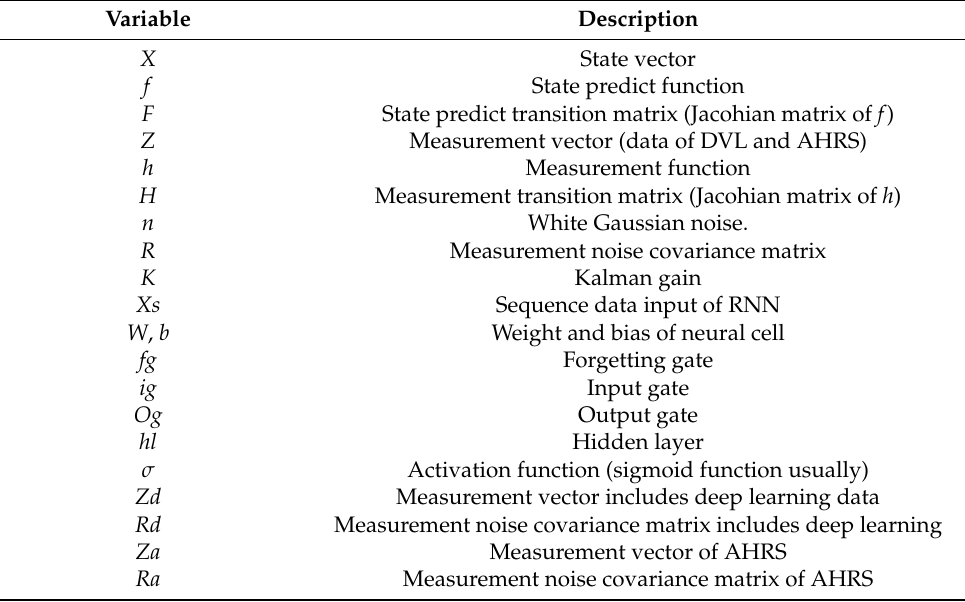
Table 5. AUV model and developed algorithm notation.